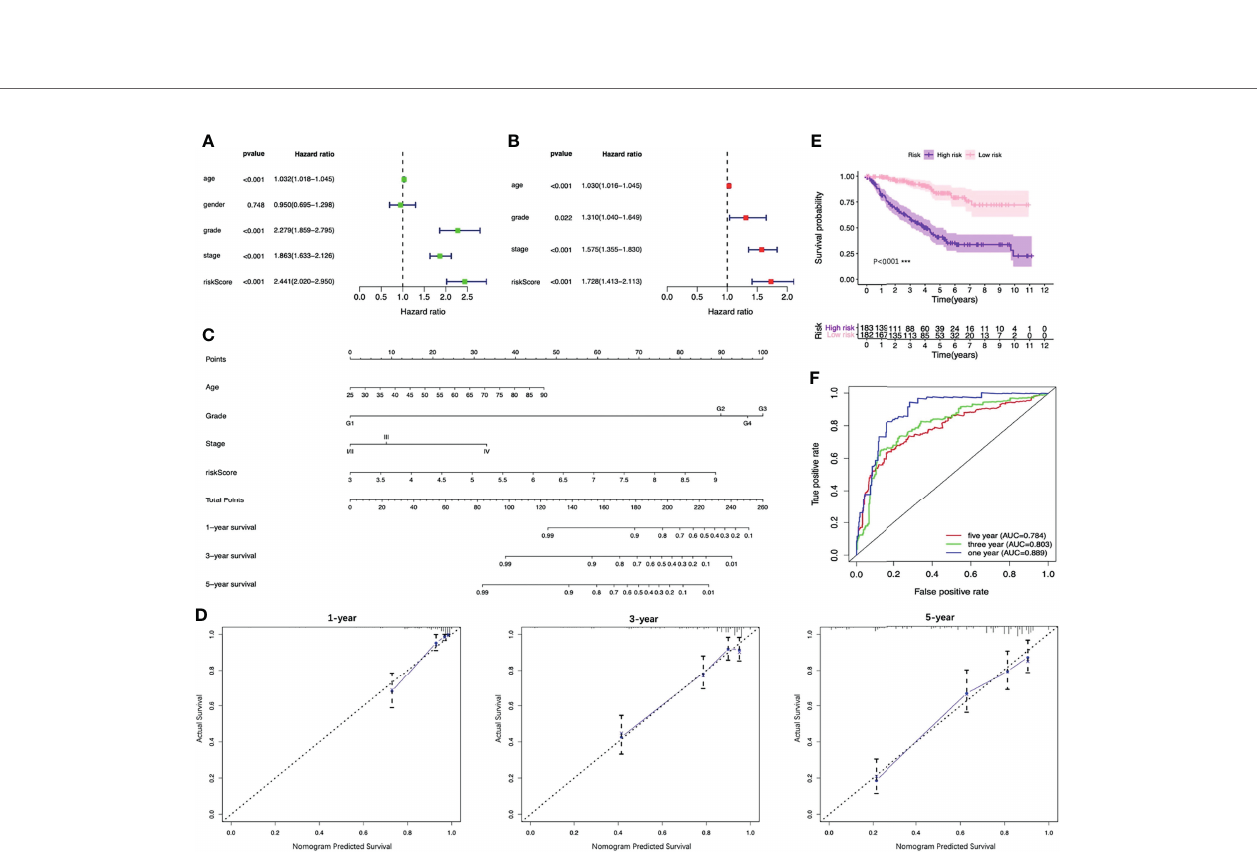
FIGURE 6 | K-M survival analysis of high-risk and low-risk patients strati fi ed by the four-FRG model in different clinical subgroups including (A) younger than 65 years old, older than 65 years old; (B) male, female; (C) grade1-2, grade3-4; (D) stage I-II, stage III-IV. K-M, Kaplan – Meier.